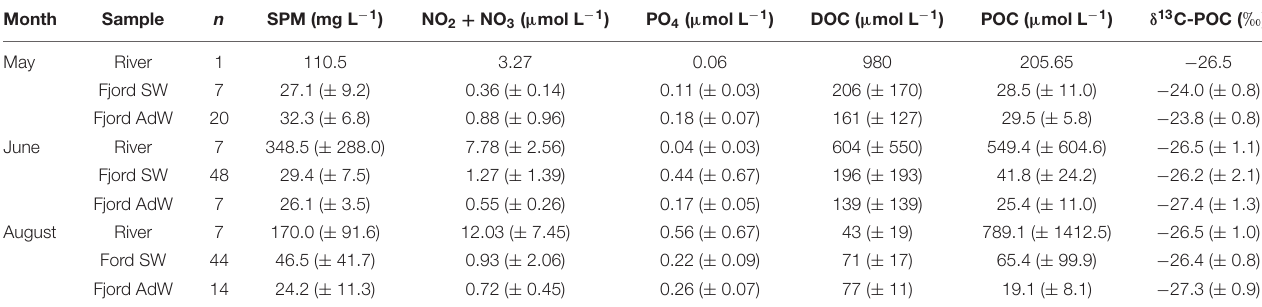
TABLE 2 | Key water chemistry parameters (averages ± SD) of river water, fjord surface water (SW), and fjord advected water (AdW) samples from 2018 to 2019 for each